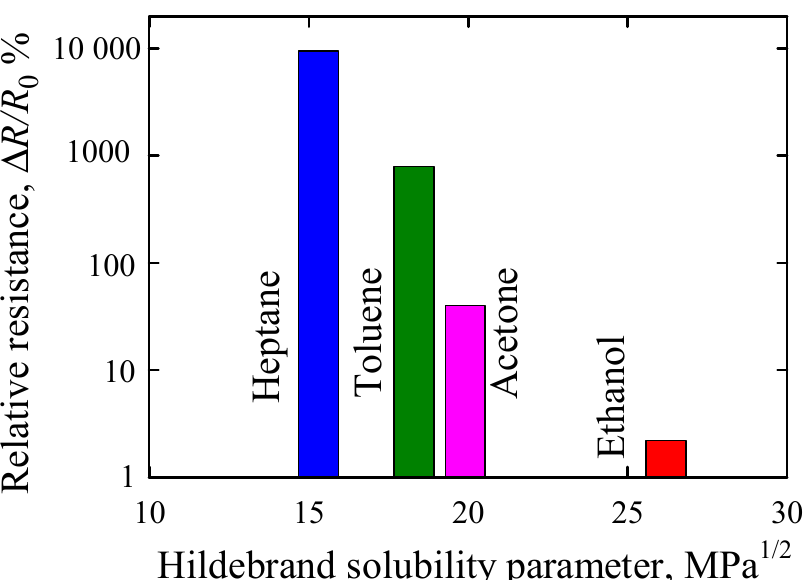
Figure 7. Dependence of changes in the relative resistance of the resistive MWCNT/EOC composite sensor on the Hildebrand solubility parameter of the indicated VOCs. Data are depicted as means of five cycle peak values of the relative resistances of the respective vapors.